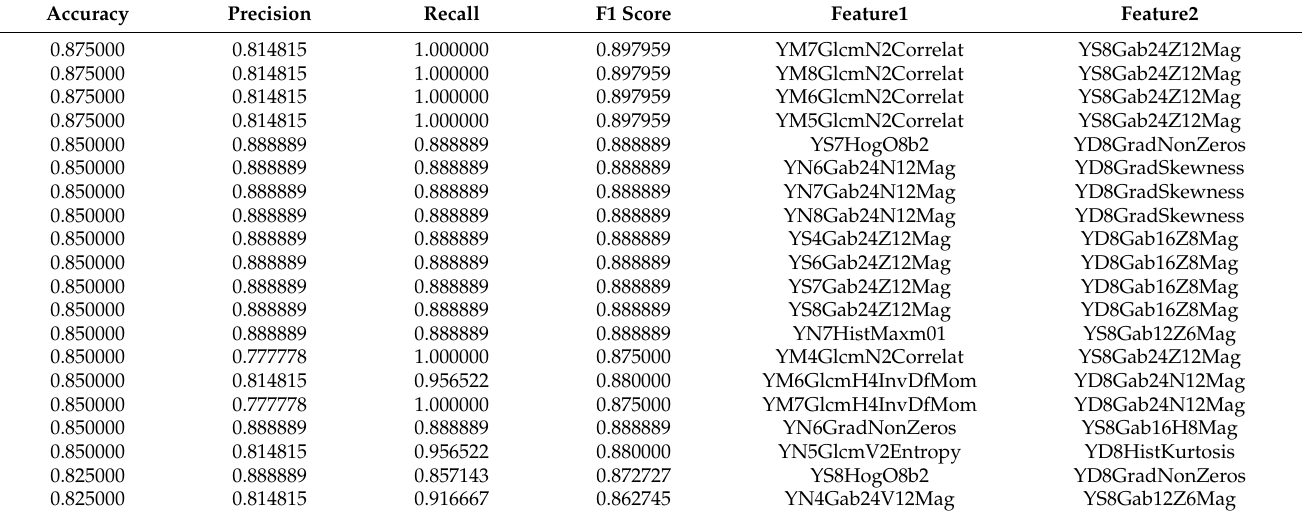
Table 5. The best 20 pairs of features when the outer prostate region is used to calculate